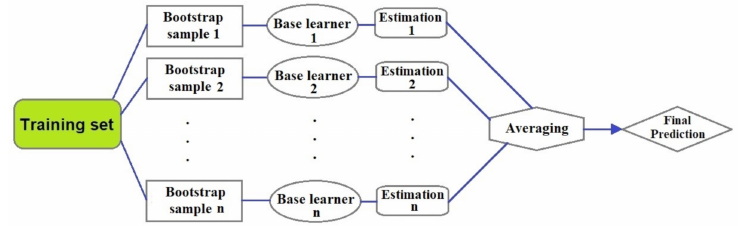
Figure 4. The random forest